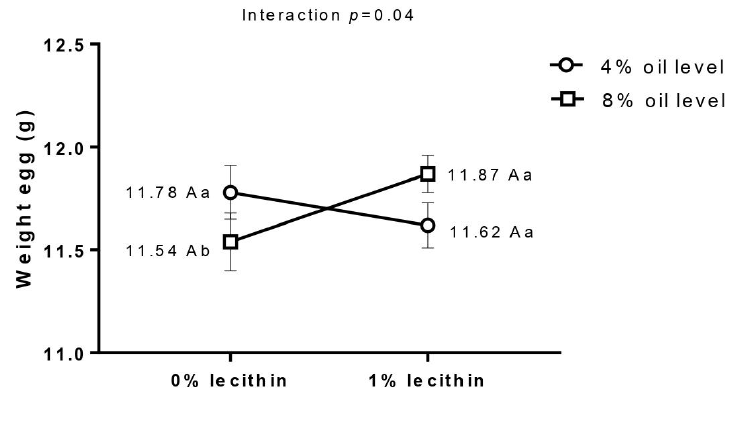
Figure 2. Effect of the interaction between level oil and the presence or